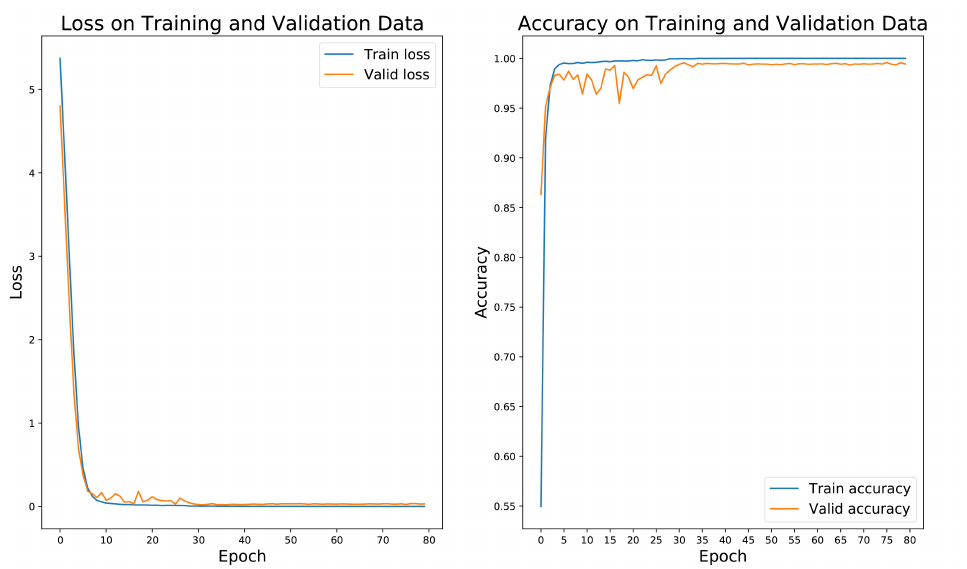
Figure 8. Loss and accuracy of the deep GRU network model with the Aishell-1 dataset. The left block presents loss vs. training epochs and the right block represents the accuracy vs. training